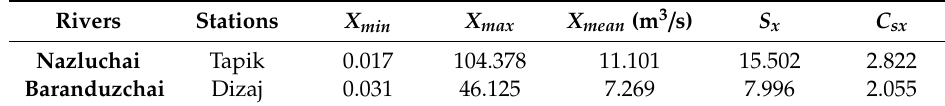
Table 2. Statistical properties of monthly streamflow